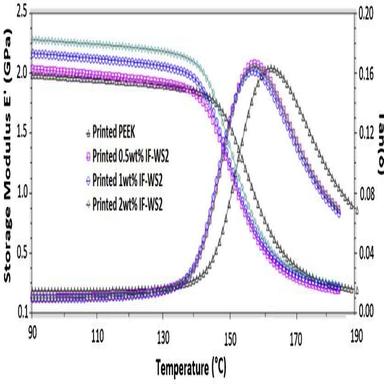
Storage modulus (E′) and Loss tangent (tanδ) vs temperature for printed PEEK samples.